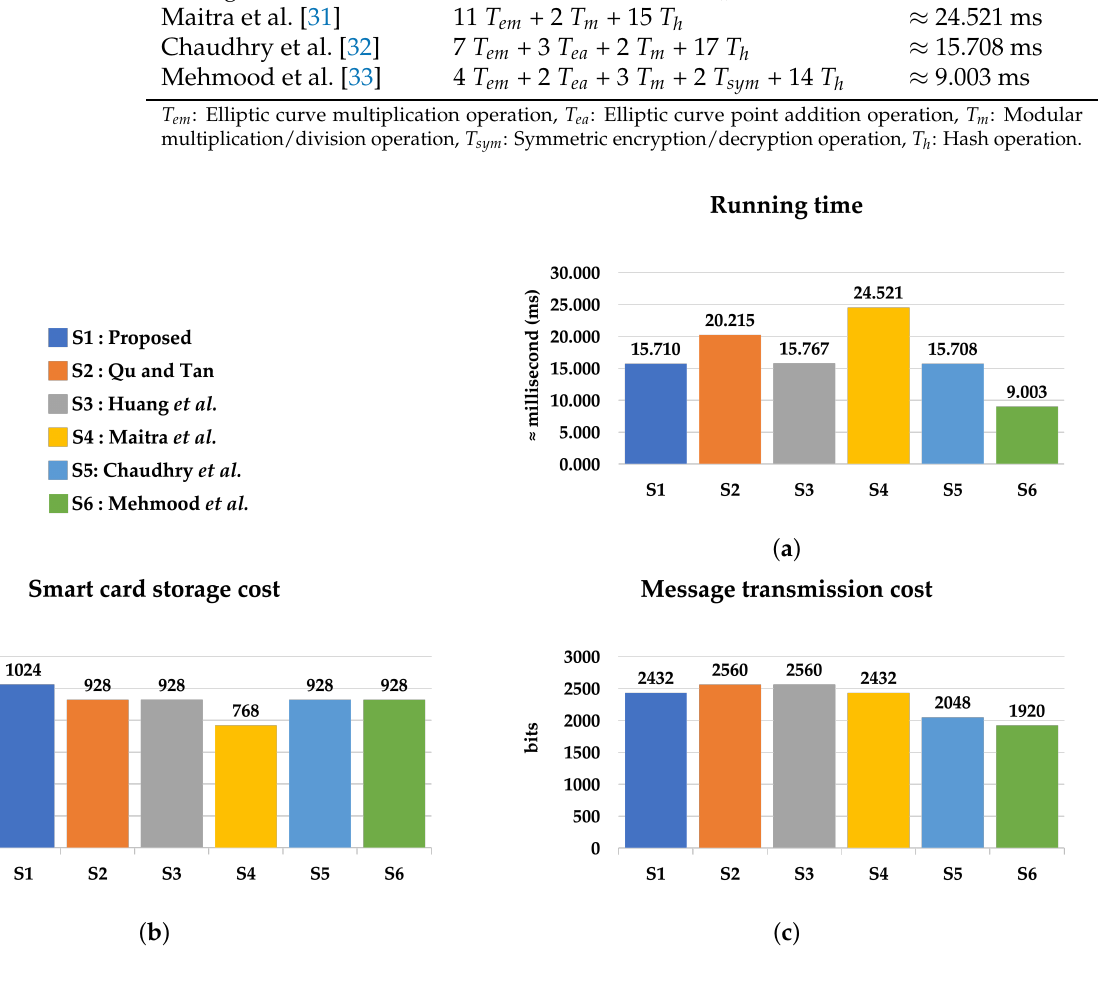
Figure 4. Comparisons of ECC-based schemes’ performance in terms of ( a ) running time; ( b ) smart card storage cost; ( c ) message transmission